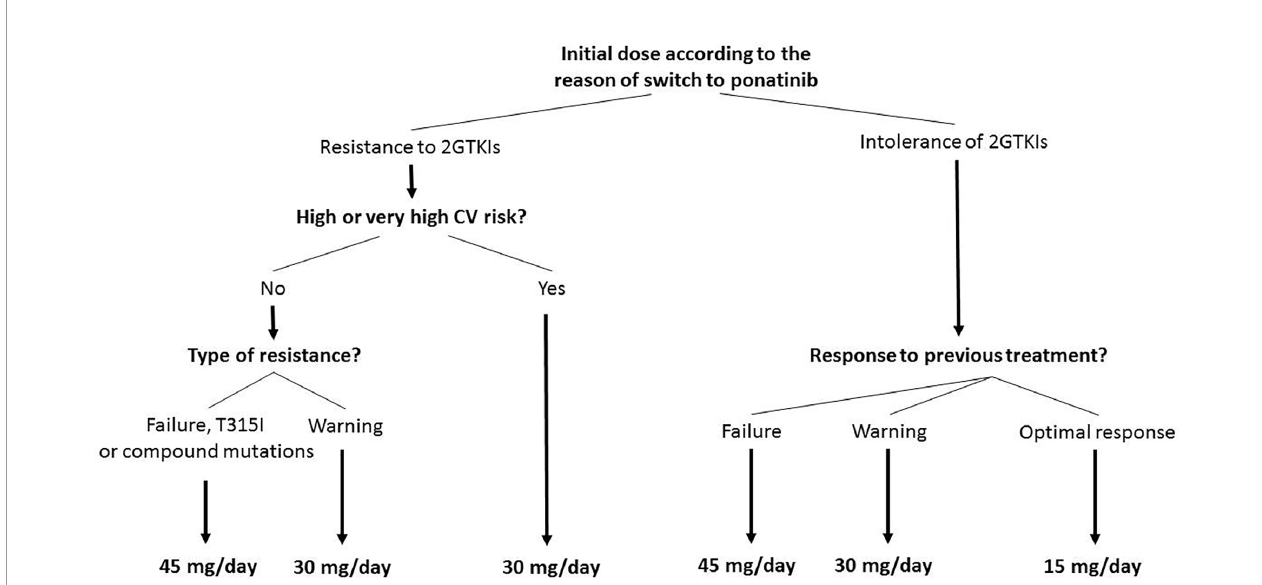
FIGURE 1 | Treatment algorithm for starting doses of ponatinib in eligible patients with chronic myeloid leukemia in chronic phase. In case of hematologic toxicity of 2 nd generation tyrosine kinase inhibitors (2GTKIs), consider 15 mg/day as initial dose. Patients with a starting dose of 45 mg/day or 30 mg/day, should reduce to 15 mg/day upon achievement of a MR3 (MR2 in case of high or very high cardiovascular [CV] risk). Failure criteria de fi ned according to the European LeukemiaNet (ELN) 2020 recommendations (BCR-ABL1 >10% within 1 – 3 months, >10% at 6 months, >1% at 12 months, and >1%, resistance mutations, high-risk additional chromosome abnormalities any time after 12 months) (7). Warning response de fi ned according to the ELN 2020 recommendations (BCR-ABL1 >10% at 3 months, >1% – 10% at 6 months, > 0.1% – 1% at 12 months onwards) (7). Optimal response de fi ned according to the ELN 2020 recommendations (BCR-ABL1 ≤ 10% at 3 months, ≤ 1% at 6 months, and ≤ 0.1% at 12 months onwards) (7). CV risk de fi ned according to the 2016 European Guidelines on CV disease prevention (25).